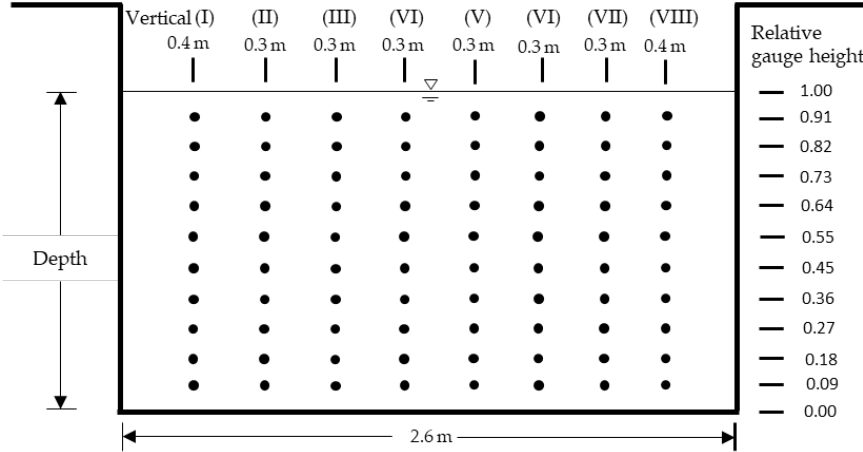
Figure 6. Discharge measurement at the Longen Channel.